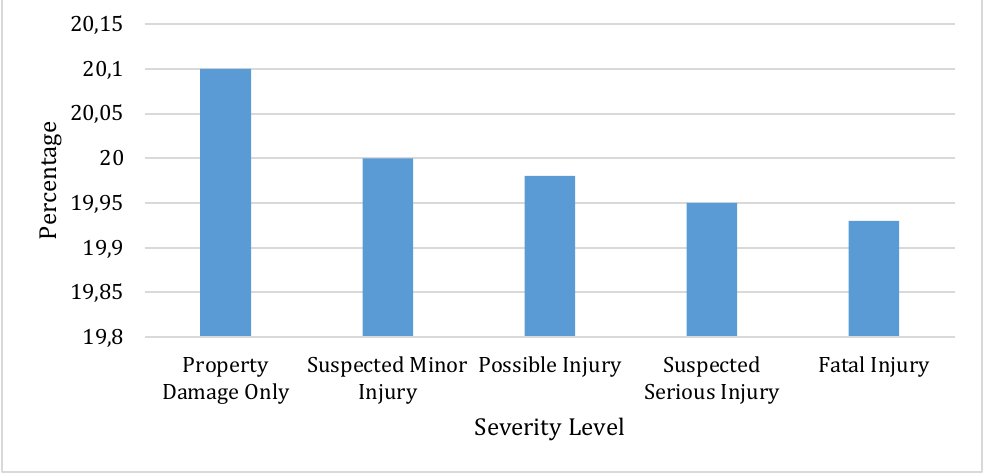
Figure 3: Training dataset after balancing using